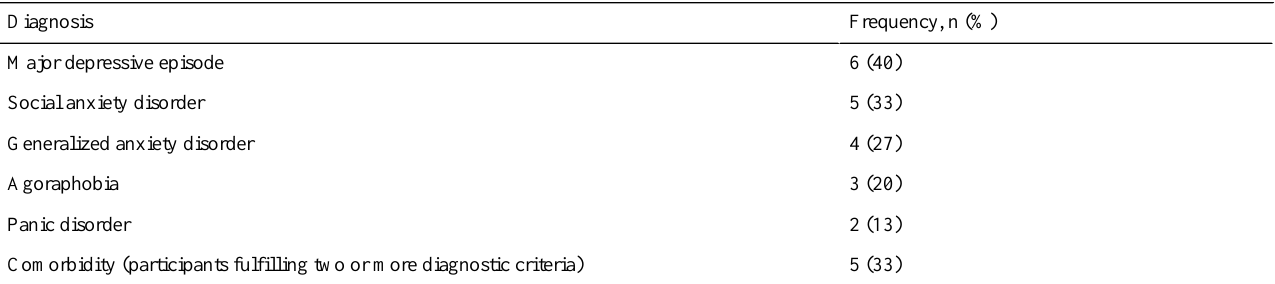
Table 2. The distribution of diagnoses according to the MINI psychiatric interviews (N=15).